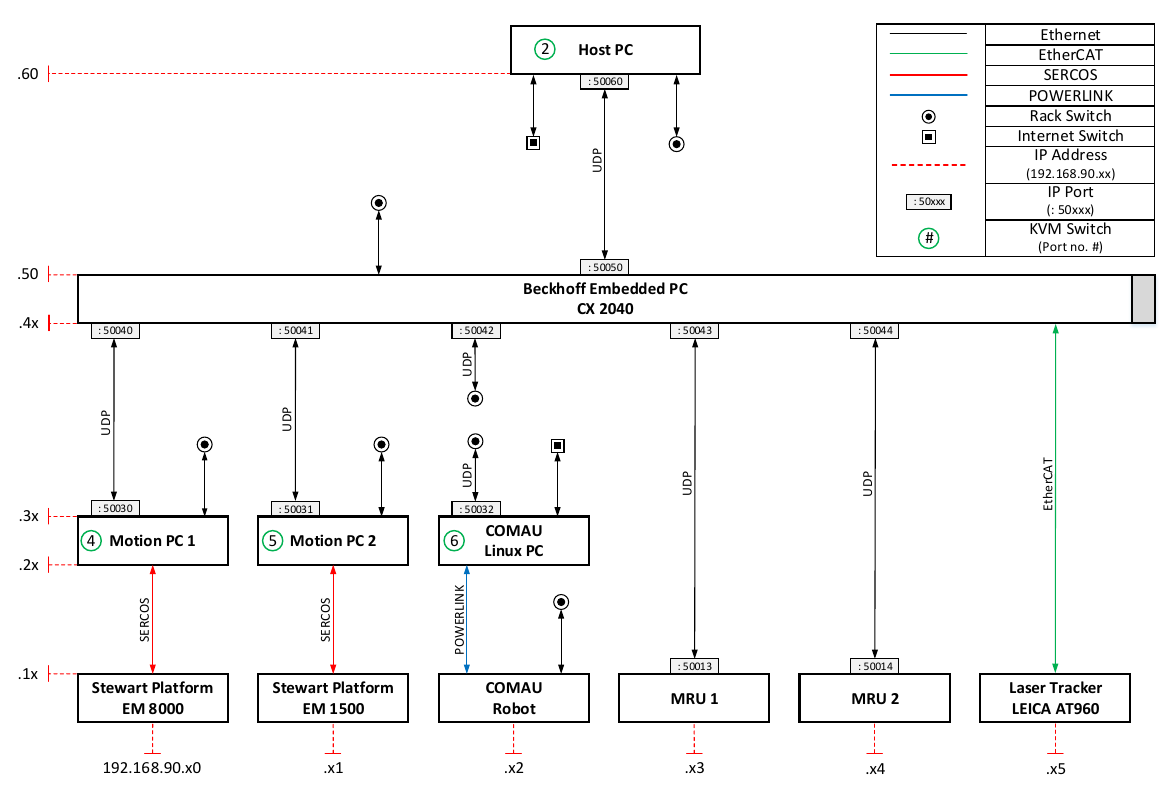
Figure 9: Overview of the connection configuration for the equipment in the Norwegian Motion-Laboratory.